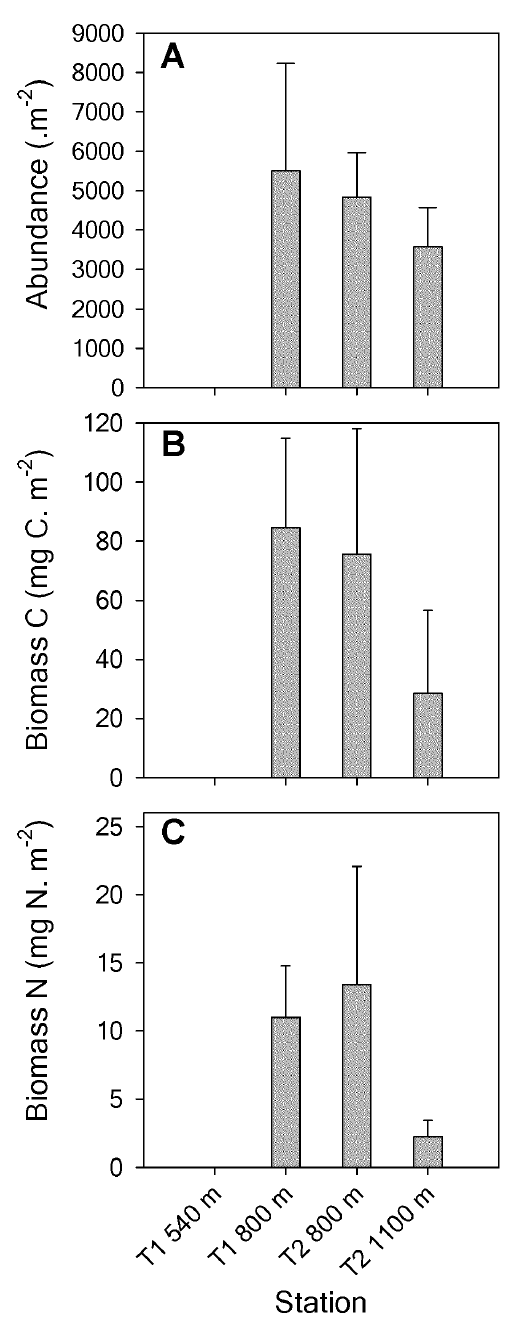
Fig. 2. Mean ( ± standard deviation) macrofaunal (A) abundance, (B) biomass C and (C) biomass N at the four experimental